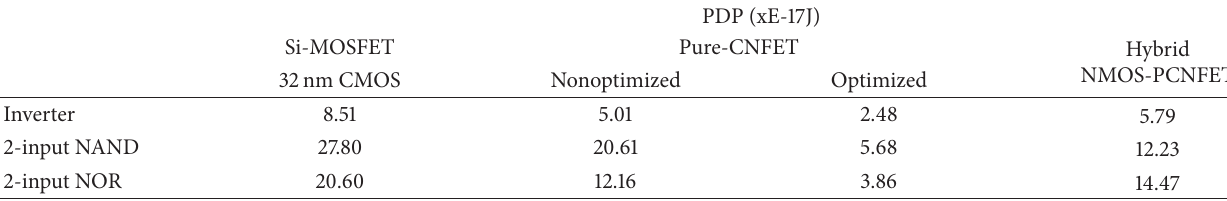
Table 6: The power delay product of inverter, 2-input NAND, and 2-input NOR gate for Si-MOS, pure-CNFET, and hybrid